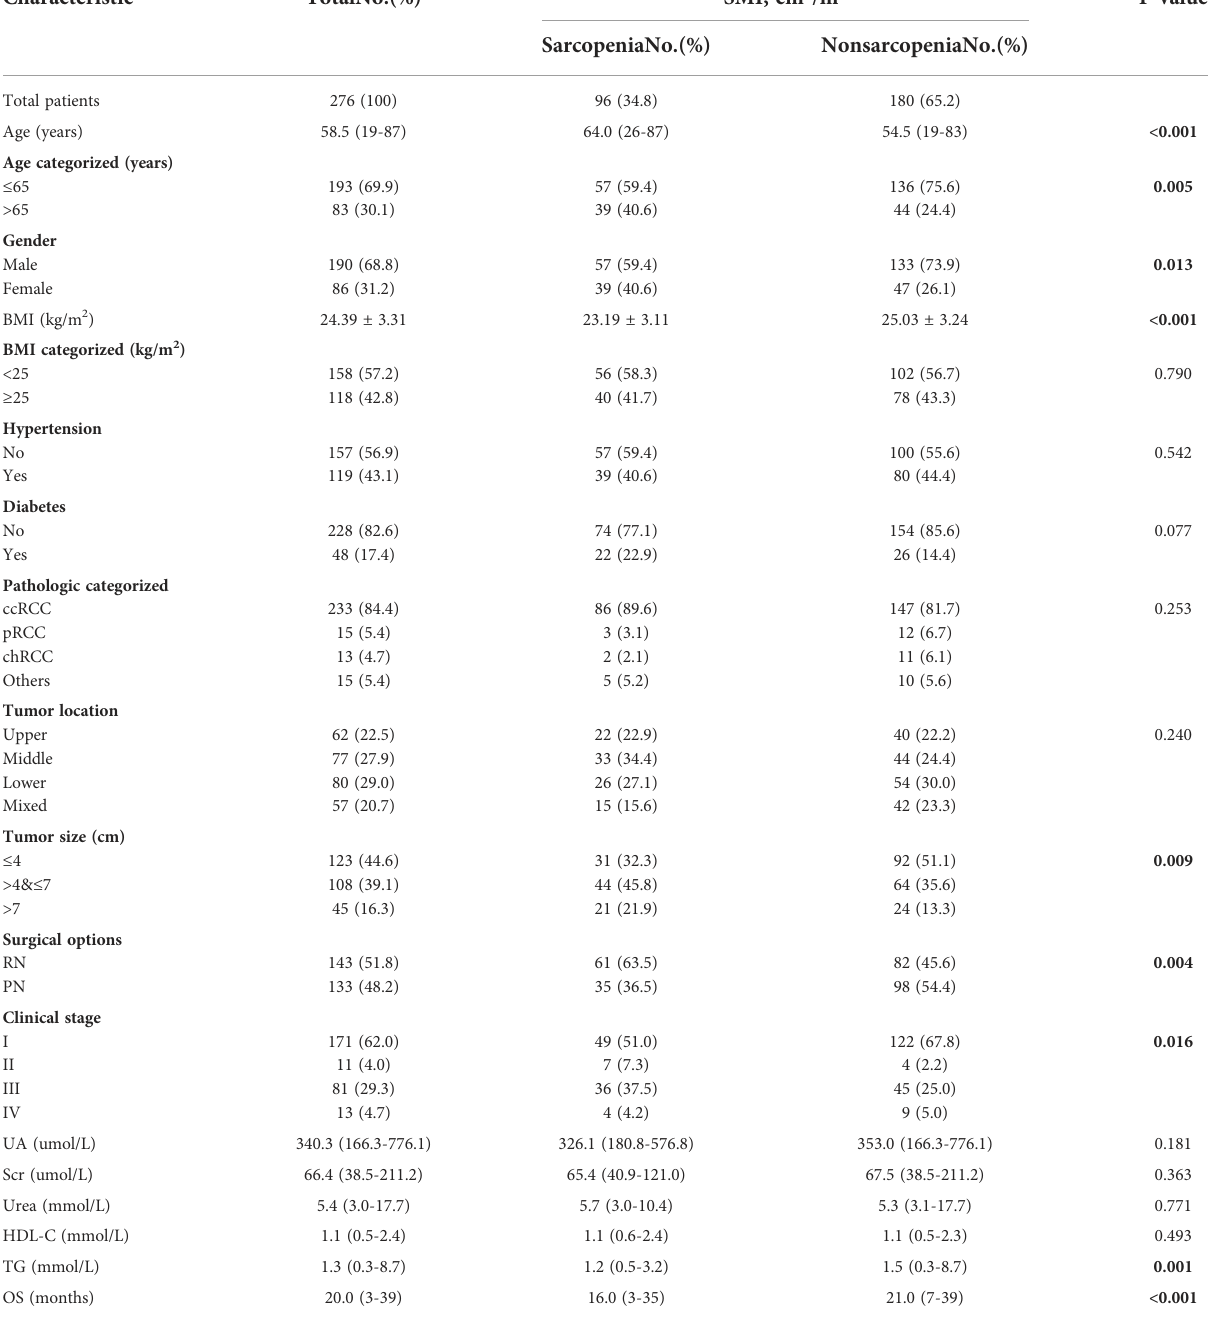
TABLE 1 Baseline characteristics with comparison between sarcopenia and nonsarcopenia